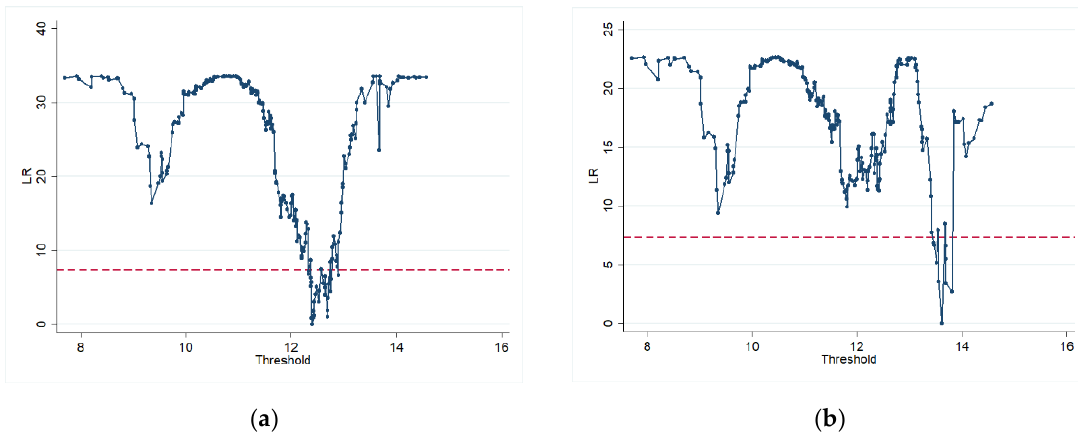
Figure 2. Estimation and confidence interval for the first threshold ( a ) and the second threshold ( b ) of energy misallocation. Table 4. Estimation results of model